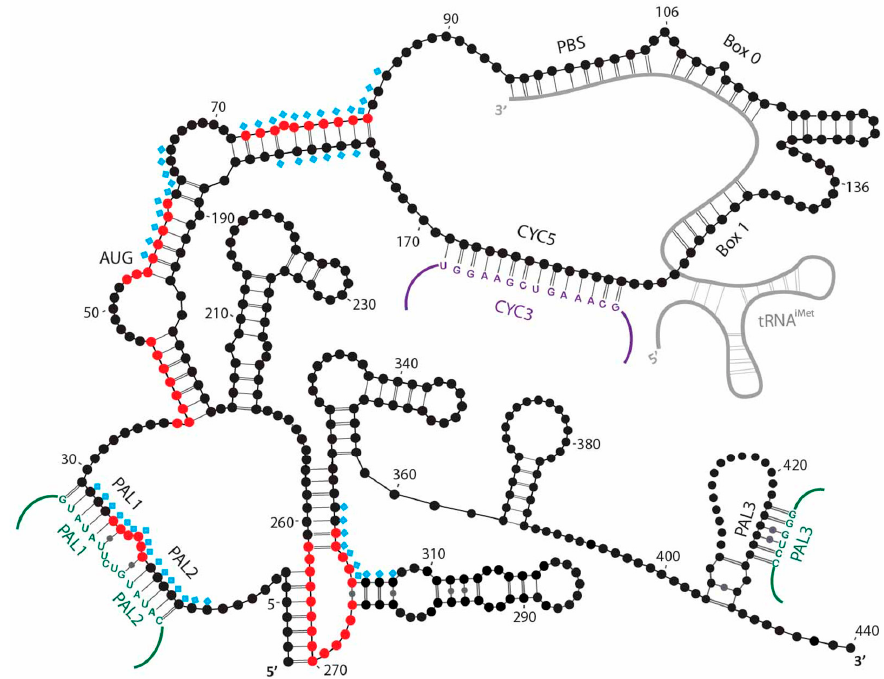
Figure 3. Secondary structure model of the 5 ′ end of Ty1 genomic RNA derived from structural analysis in different biological states by selective 2'-hydroxyl acylation analyzed by primer extension (SHAPE) [61]. Nucleotide positions at which SHAPE reactivities increased when proteins were gently removed from VLP-associated Ty1 genomic RNA are marked with blue diamonds. Those positions most likely correspond to Gag binding sites within the dimeric Ty1 genomic RNA in VLPs. Regions in monomeric Ty1 RNA mapped in vitro as binding sites for Gag C-terminal region are represented in red [62]. Palindromic (PAL) sequences, including reciprocal interstrand interactions are annotated in green [61], and cyclization mediated by CYC5 and CYC3 in violet [63]. tRNAiMet is essential for Ty1 and Ty3 retrotransposition. Using mutational analyses Ty1 gRNA